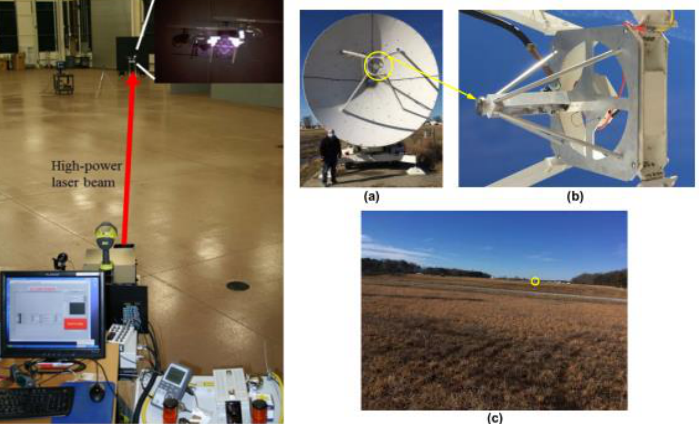
Figure 12. WPT experiment in naval laboratory. Reproduced with permission from Ref. [50]; pub- lished by IEEE, 2022. ( a ) a 5.4-m-diameter parabolicreflector; ( b ) a linearly actuated horn; ( c ) a view of the transmitter from the target site 1046 m away.